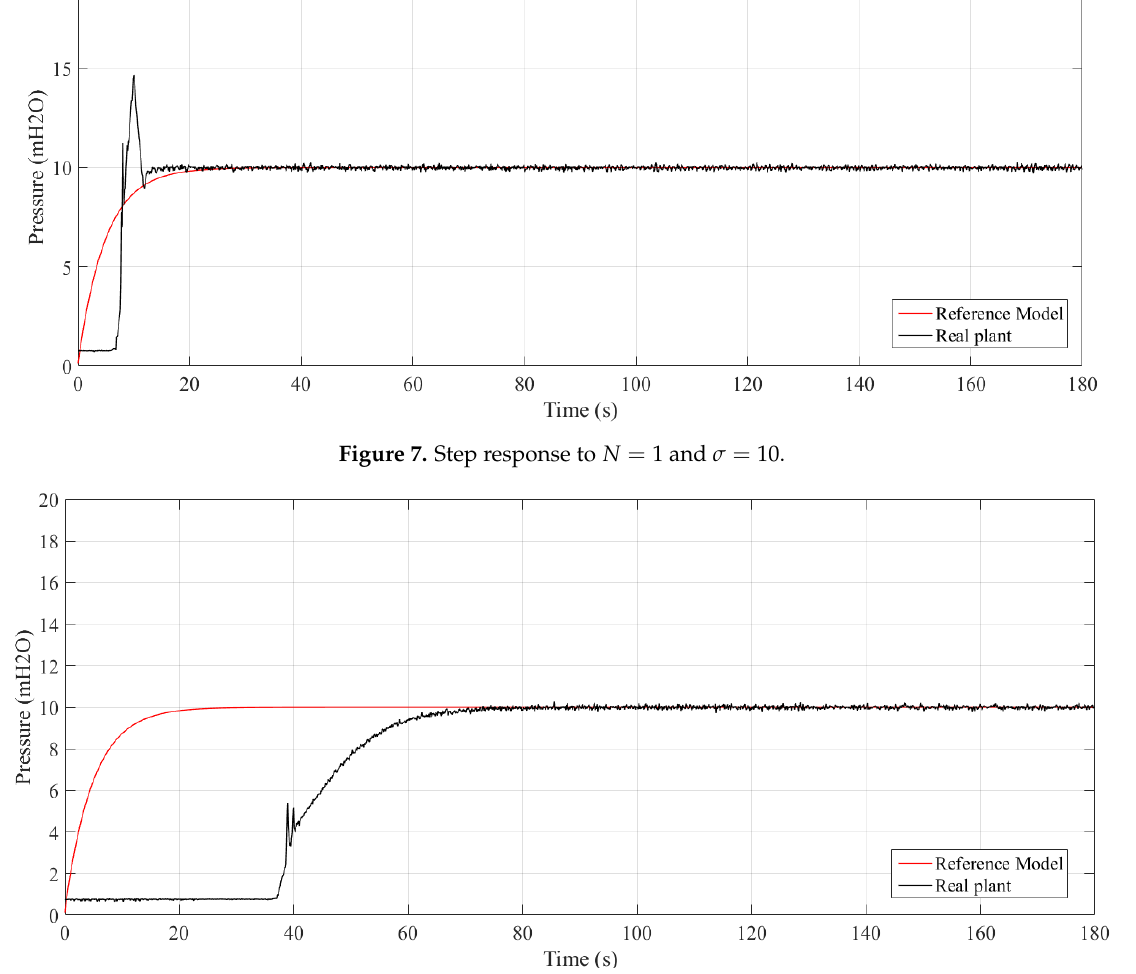
Figure 8. Step response to N = 20 and σ =